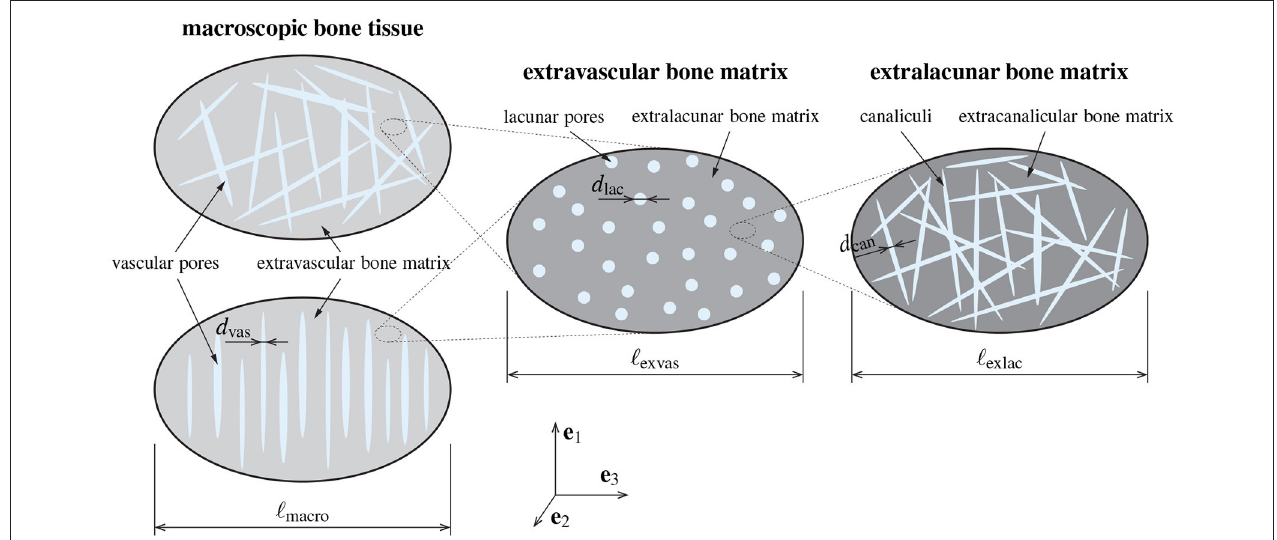
FIGURE 1 | Model representation based on which permeability upscaling and pressure gradient downscaling is performed, including the RVE of macroscopic bone tissue (left) , containing vascular pores (oriented arbitrarily or longitudinally) and extravascular matrix, the RVE of extravascular bone material (middle) , containing lacunar pores and the extralacunar bone matrix, and the RVE of extralacunar bone material (right) , containing canalicular pores and extracanalicular bone matrix.